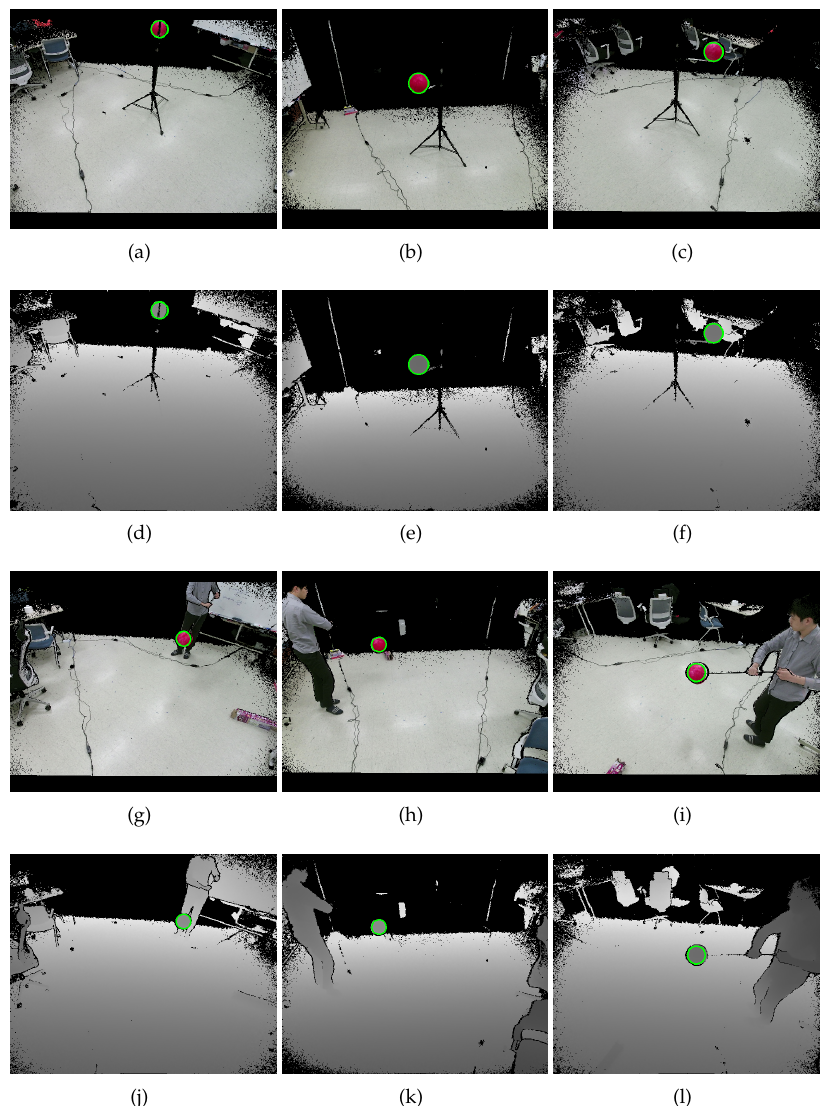
Figure 11. Examples of aligned and undistorted color and depth image pairs acquired by three Kinect v2 cameras. From ( a – f ), we have collected a static set by capturing still images of a static sphere. From ( g – l ), we have collected a dynamic set by capturing videos of a sphere carried by a person. The green empty circles represent sphere regions detected by the proposed method.